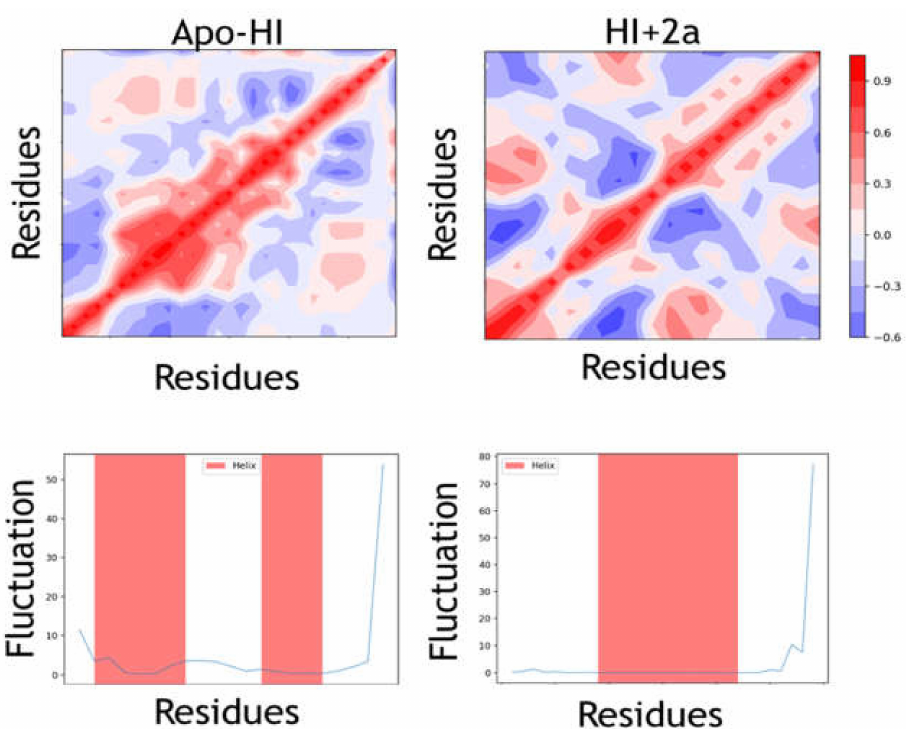
Figure 10. Normal mode analysis of 2a . The upper panel (right with 2a and left) indicates the correlation. The color bar indicates the positive (red) and negative (blue color) correlation. A stronger correlation indicates a more compact structure, while a negative correlation indicates a move-away behavior, which subsequently increases the plasticity of the structure, where it would be very easy for any compound to dissociate. The lower panel indicates the residue